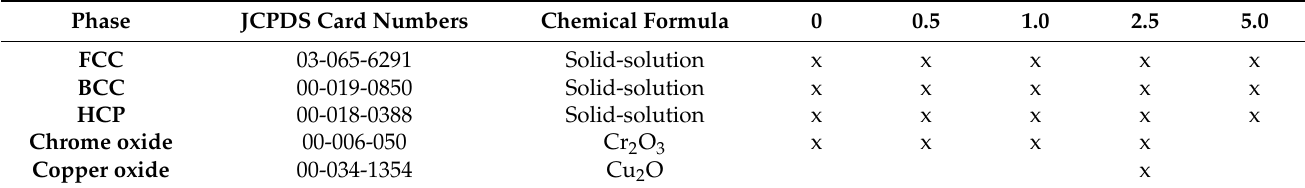
Table 1. Indexed phases found in the diffraction patterns of Figure 1.